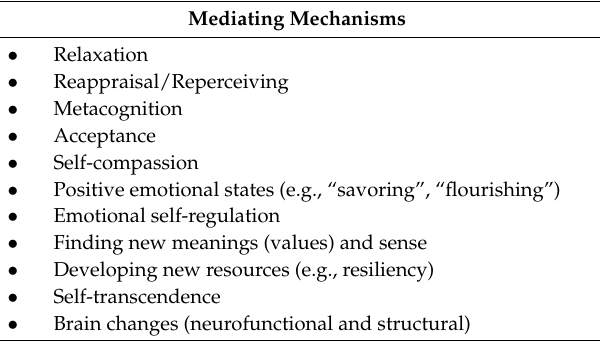
Table 2. Mediating mechanisms for the efficacy of